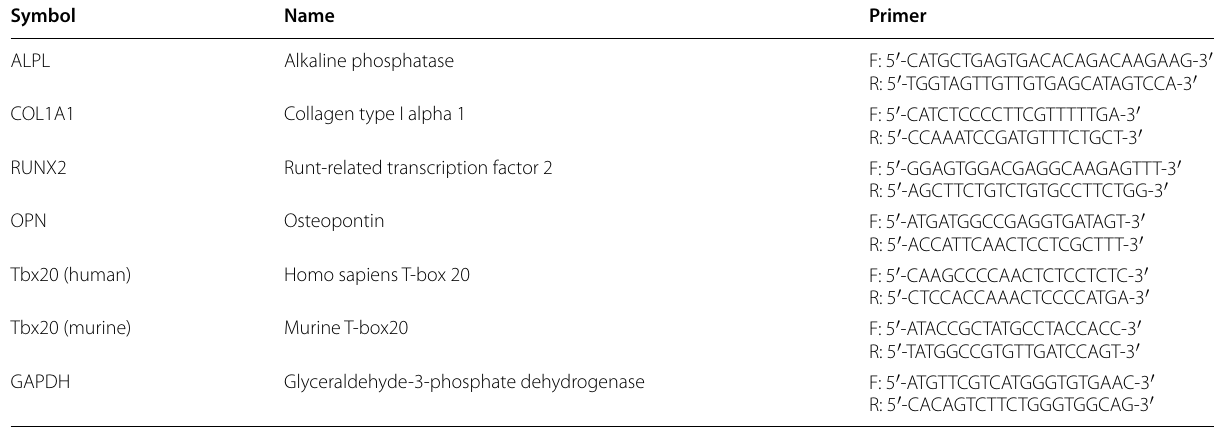
Table 1 RT-qPCR